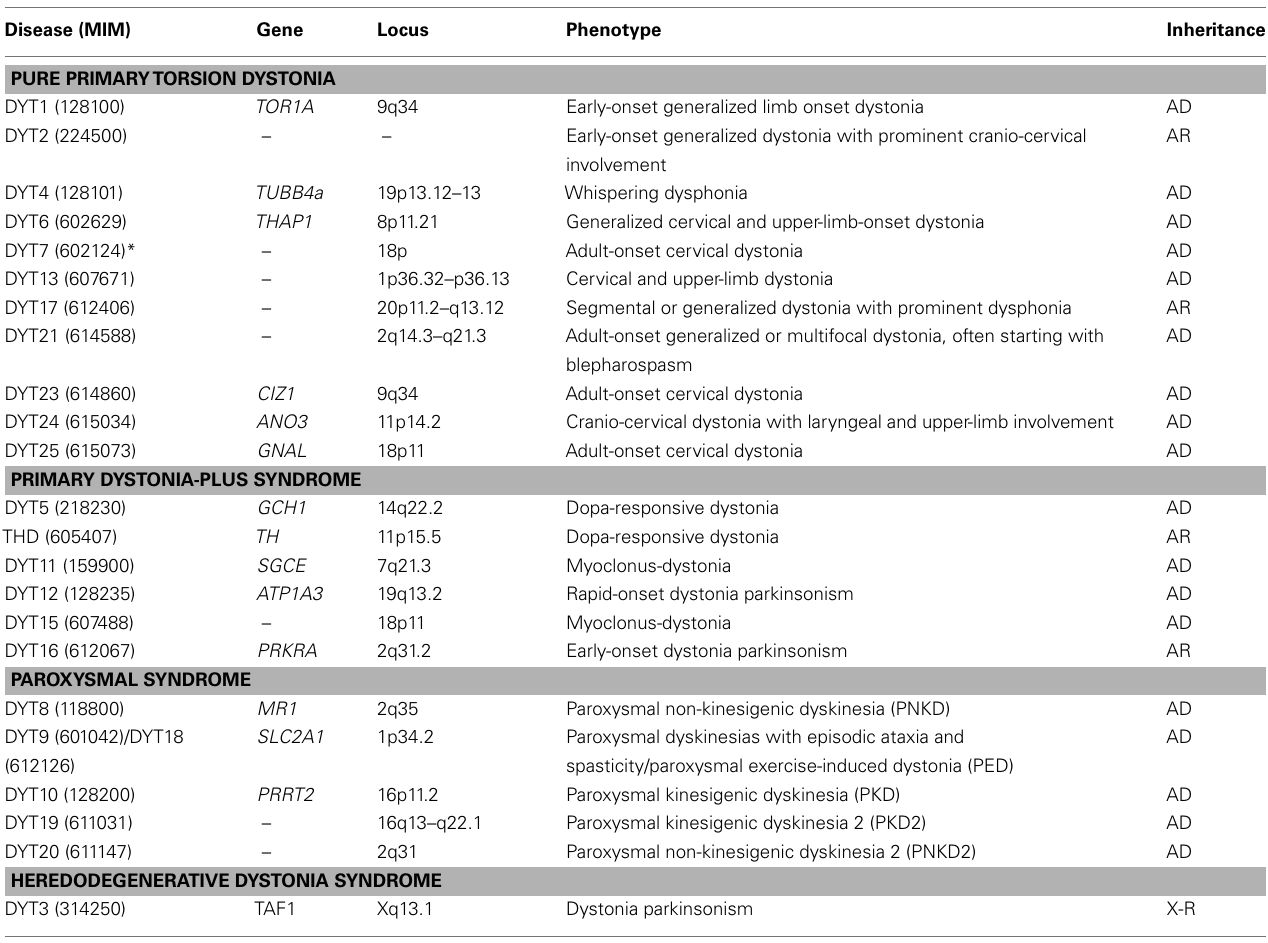
Table 1 | Molecular classification of “DYT” dystonia